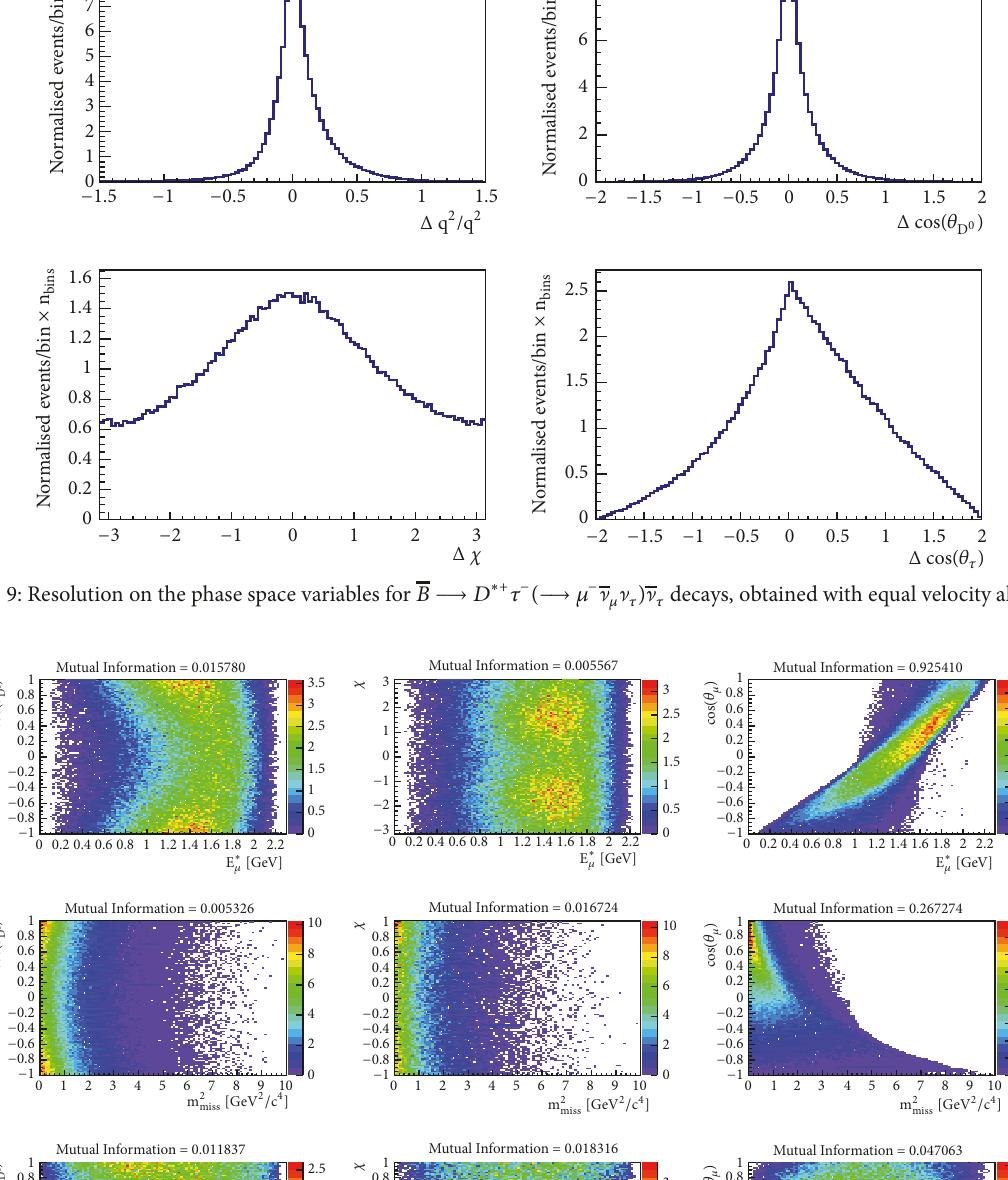
0 0.20.40.60.8 1 1.21.41.61.8 2 2.2